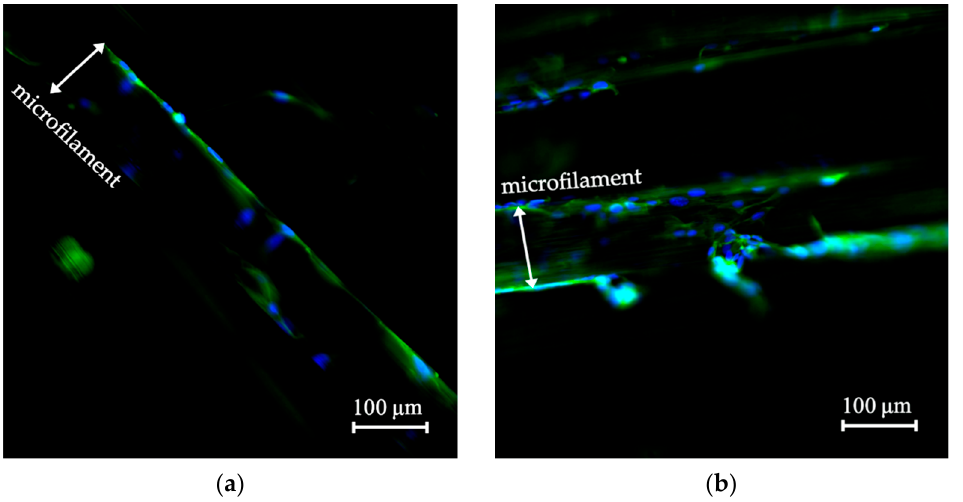
Figure 9. ( a ) Microfilament after 24 h of mechanical stimulation and ( b ) microfilament without mechanical stimulation. Both micrographs were taken at 20 × where actin filaments of the cytoskeleton are visible in green, and nuclei are visible in blue.